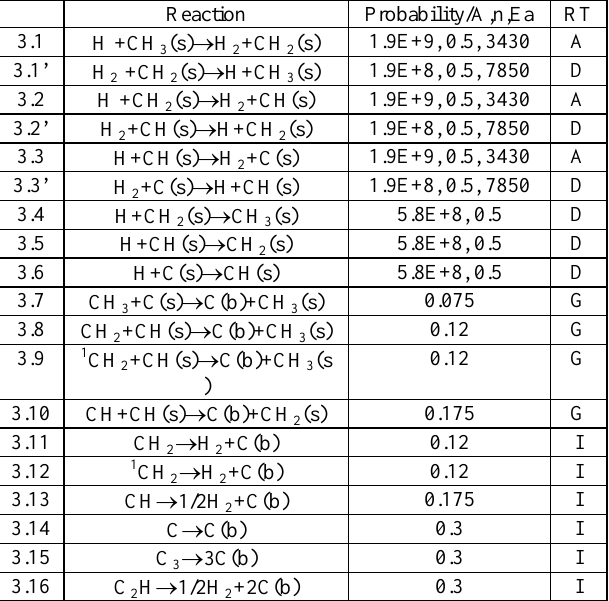
Table 5. Probabilities of the surface reactions on the wafer, model 3. Notations are as in table 4.